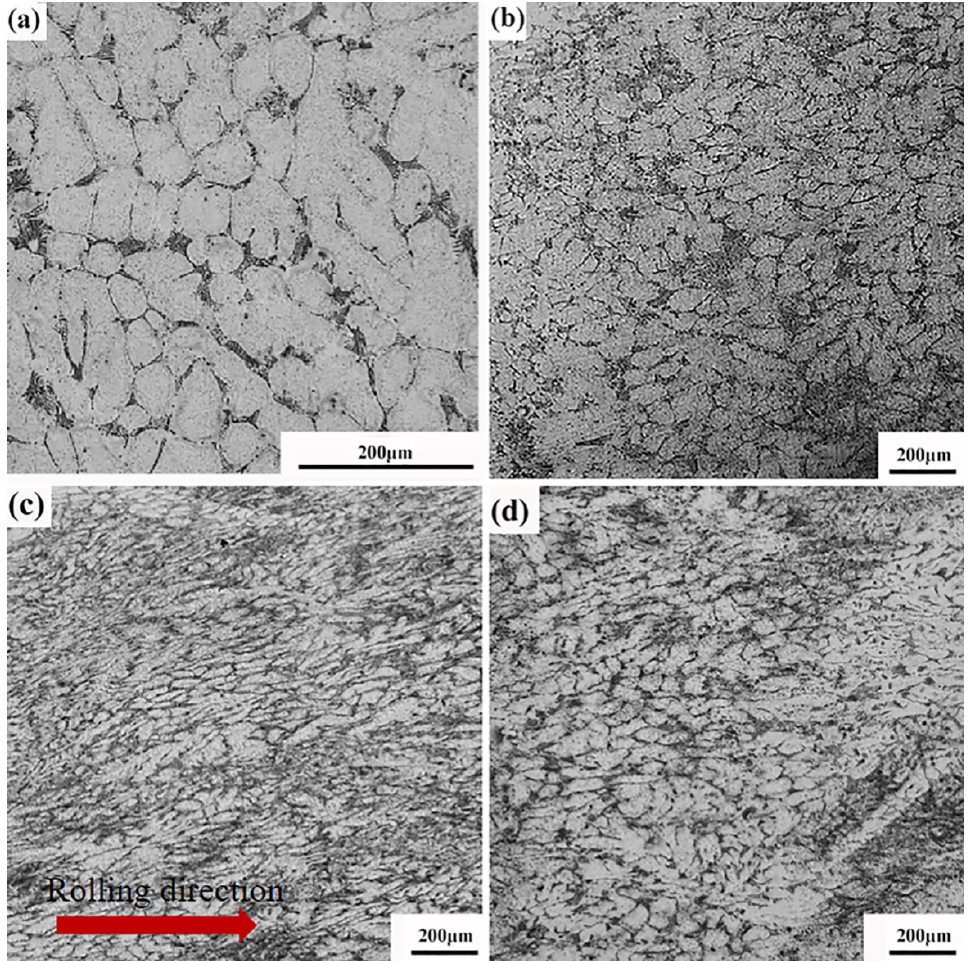
Figure 1. Microstructures of GAZ 211 alloy in different states: ( a ) homogenization at 673 K for 16 h, ( b ) multidirectional forging (723 K), 3rd pass, ( c ) multidirectional forging (723 K) and hot rolling (693 K), longitudinal direction (rolling direction), and ( d ) annealing at 723 K for 1 h.